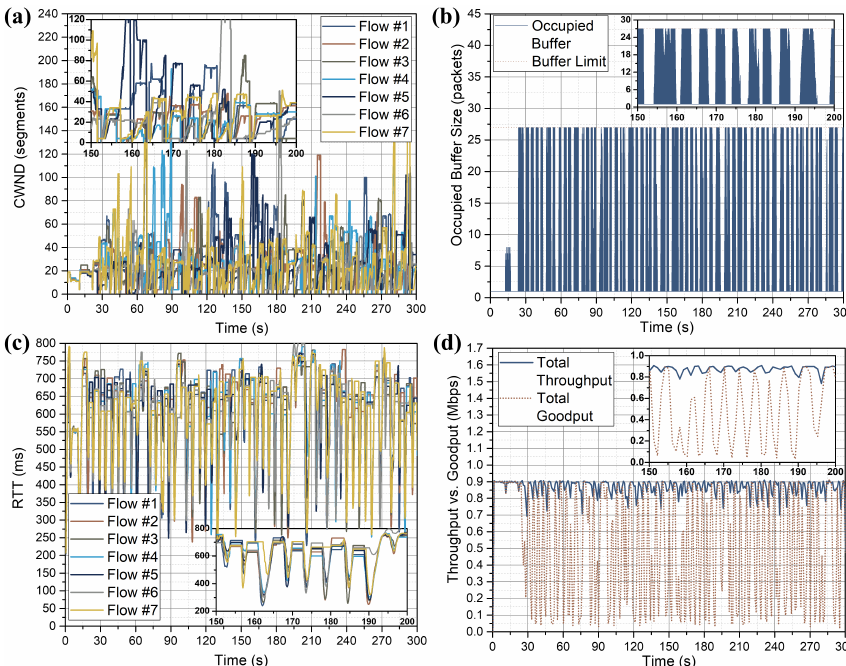
Figure 5. In the simulation experiment, the performance of the bottleneck bandwidth and round-trip time (BBR) congestion control algorithm in terms of ( a ) congestion window (CWND), ( b ) occupied buffer size, ( c ) round trip time (RTT), and ( d ) throughput vs.